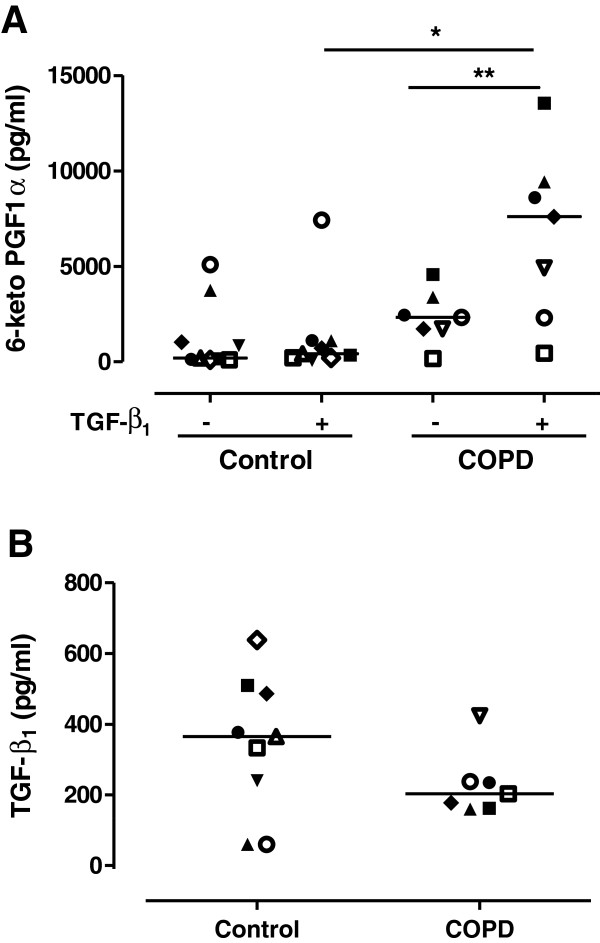
A. Prostacyclin production is increased in COPD fibroblasts after TGF-β1 stimulation. Prostacyclin synthesis was measured as 6-keto PGF1α in the supernatant from distal lung fibroblasts from control subjects (n = 9) and patients with COPD (n = 7). Cells were stimulated with TGF-β1 (10 ng/ml) in 0.4% fibroblast medium. Data are presented as median with individual values and median values are represented as a line. *p < 0.05, **p < 0.01. Statistical analysis is performed with Mann Whitney test to compare differences between control and COPD fibroblasts and Wilcoxon paired rank sum test is used to analyze differences within the control and COPD fibroblasts after TGF-β1 stimulation. B. There is no difference in endogenous TGF-β1 production in control or COPD fibroblasts. TGF-β1 production measured in supernatant from distal lung fibroblasts from control subjects (n = 9) and patients with COPD (n = 7). Data are presented as median with individual values and median values are represented as a line. Statistical analysis is performed with Mann Whitney test to compare differences between control and COPD fibroblasts.